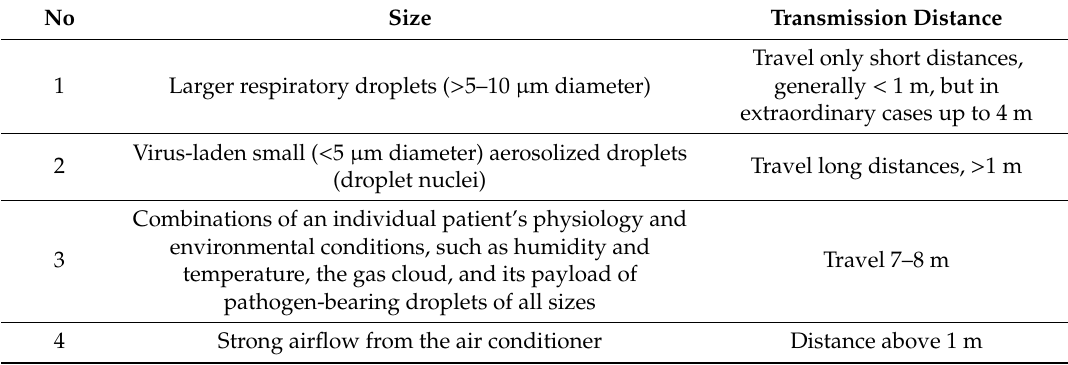
Table 1. Propagation of human coronavirus through air